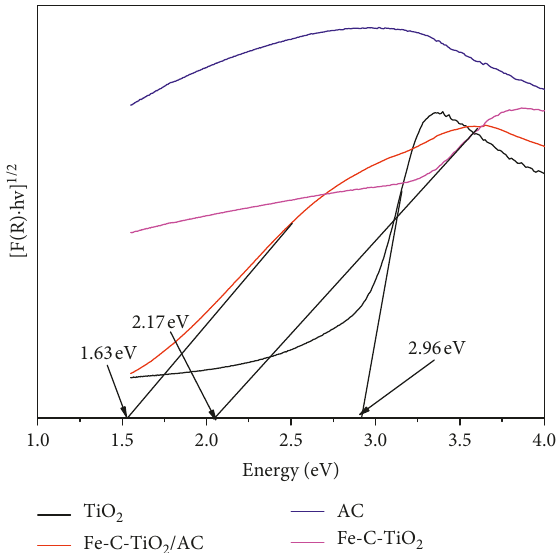
Figure 7: Plot of [F(R) · h ν ] 1/2 vs energy (eV) for pure AC, Fe-C-TiO